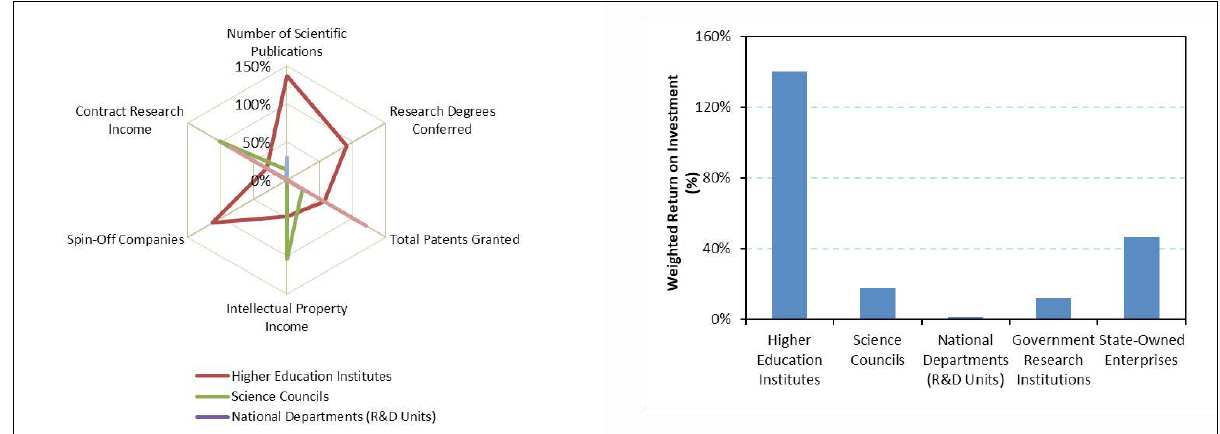
figure 3: Comparison of the outputs from public-funded R&D at public